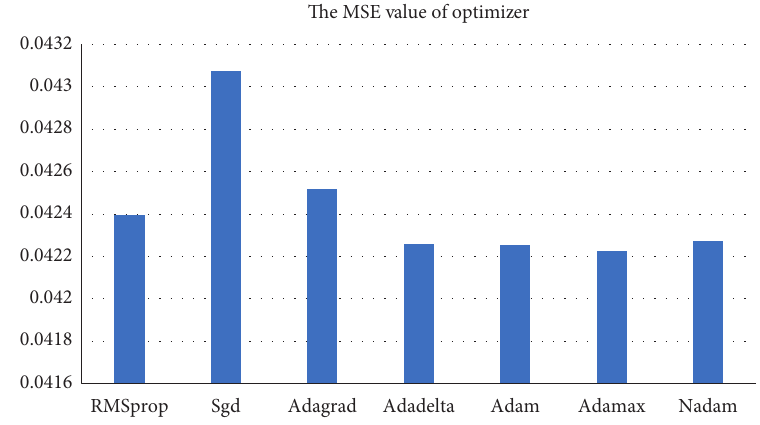
Figure 5: The optimizer Table 3: The activation functions comparison.